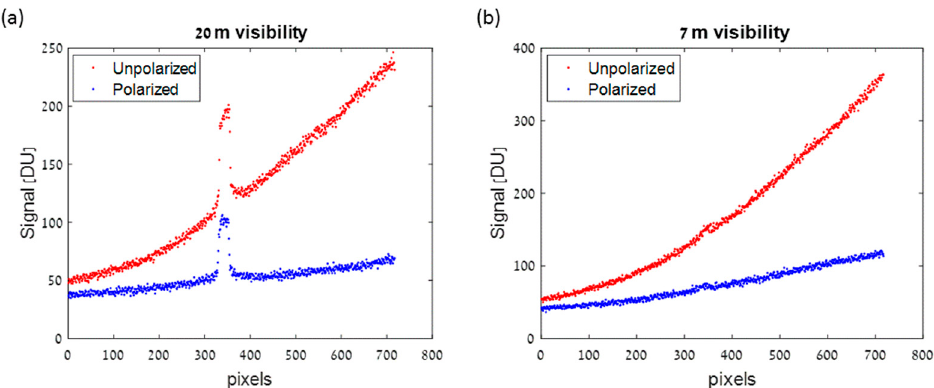
Figure 7. Received video line signal at polarized, (blue line) and unpolarized (red line) cameras. The video line contains a black background with a white object at the middle of the frame. The target width (about 8 cm) corresponds to 23 pixels. ( a ) At cloud visibility range of 20 m, the white object can be clearly seen. ( b ) Taken at a visibility range of 7 m, the object cannot be observed despite the very similar received cloud signal at the polarized camera.